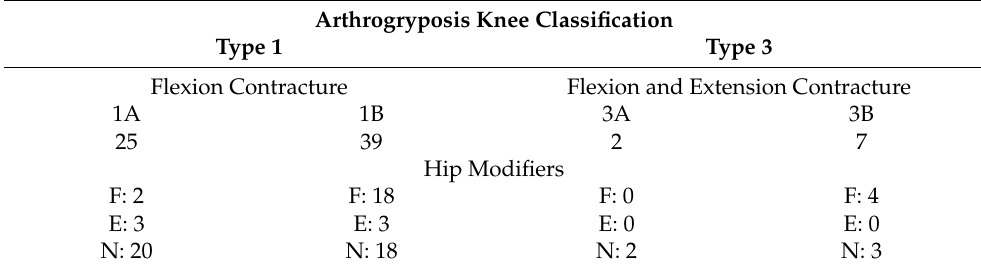
Table 2. Distribution of patients analyzed by knee